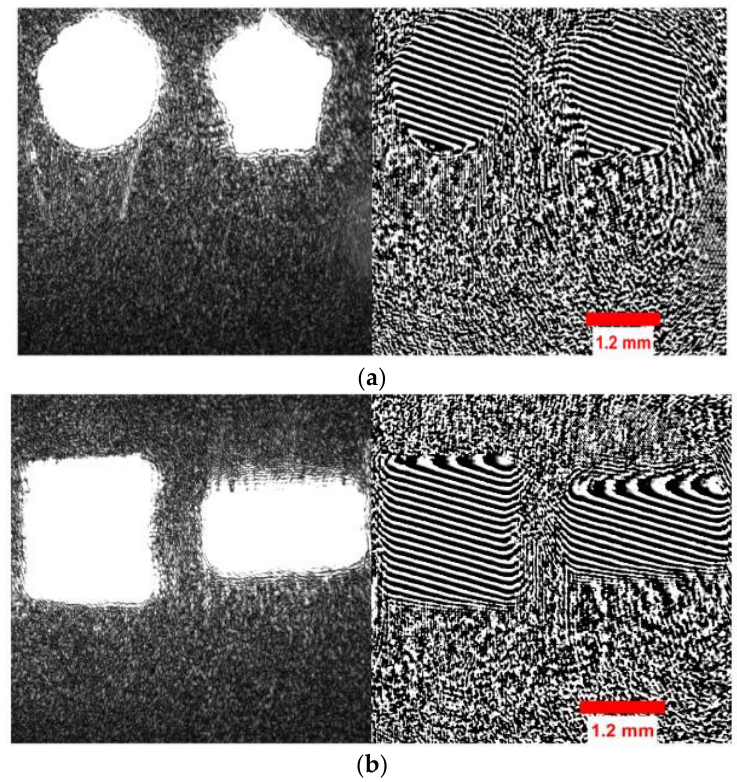
Figure 5. ( a ) Concatenated intensity – phase image of the circle – pentagon ( 𝑅𝑎 𝑑1,𝐼𝑁𝑃𝐻 ) object that belonged to Class-a; ( b ) concatenated intensity – phase image of the square – rectangle ( 𝑅ℎ 𝑑1,𝐼𝑁𝑃𝐻 ) object that belonged to Class-b.